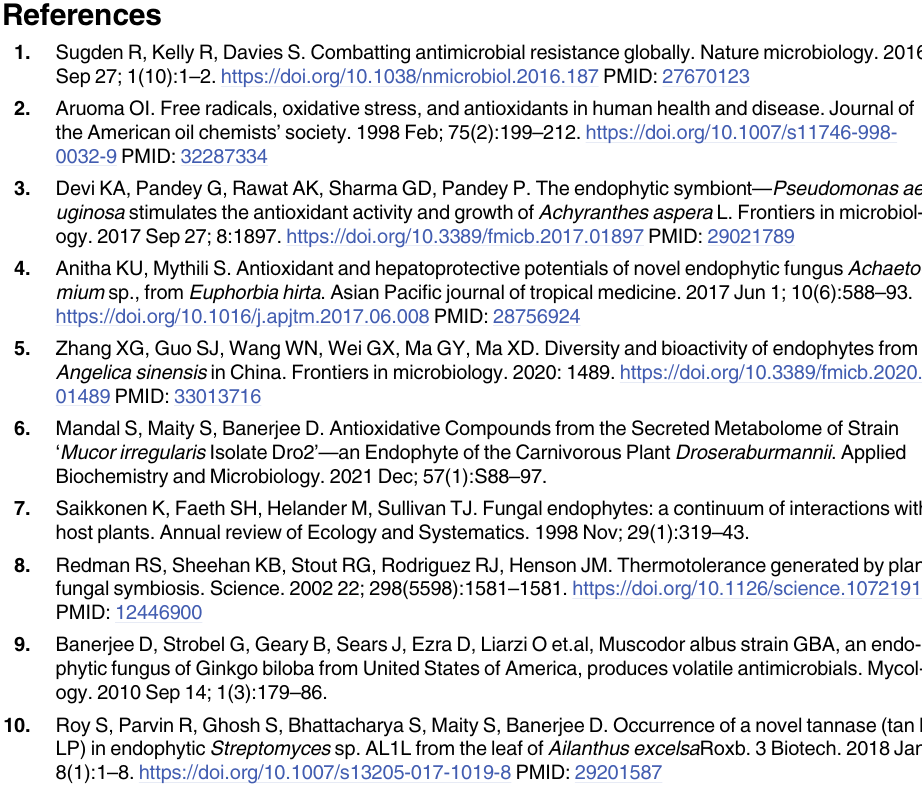
S3 Fig. Chemical structures of the bioactive compounds derived from NIST library. (DOCX) S4 Fig. a Electron-ionisation mass spectrum of bisabolol obtained from LCS1 extract. b Elec- tron-ionisation mass spectrum of standard bisabolol. S1 Table. a. Antibacterial activity (in terms of clear zone of inhibition in mm) of the endo- phytic isolates against pathogenic bacteria. b MIC values ( μ g/mL) of culture extract and